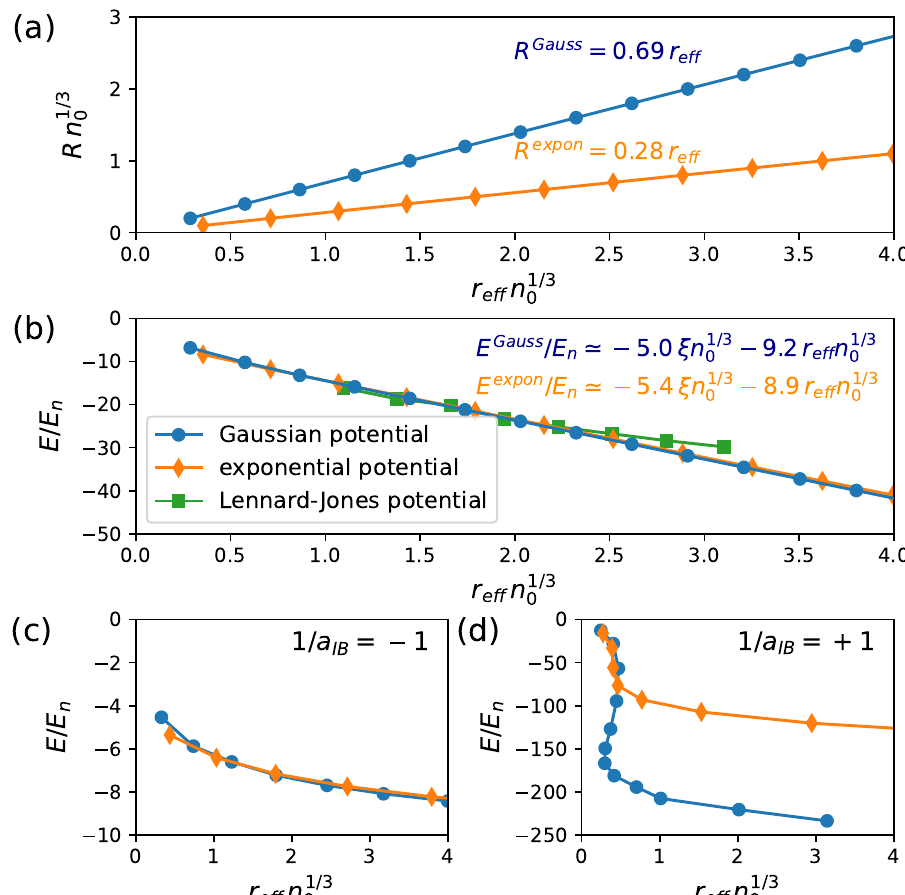
Figure 5: Universality of the Bose polaron. (a) In order to yield the same effective range r , the Gaussian and exponential potentials need to be tuned to different eff = 0. (b) potential ranges R ; here shown for fixed unitary scattering length 1 / a IB = 0 for two Polaron energy E as function of the effective range r at unitarity 1 / a eff IB / 3 / m ) a = 1. n 1 different potential shapes. The boson repulsion is set to 8 π ( m red B BB 0 The polaron energy coincides for both potential shapes and increases linearly with r . This universality also extends to Lennard-Jones potentials as shown by the green eff / 3 = − 1 is n 1 squares. (c) The polaron energy at negative scattering length 1 / a IB 0 / 3 (cid:166) 1 for the parameters chosen. (d) Polaron energy at positive n 1 universal for r eff 0 / 3 = 1. For the Gaussian potential there is no unique polaron n 1 scattering length 1 / a IB 0 energy for intermediate values of r (see eff